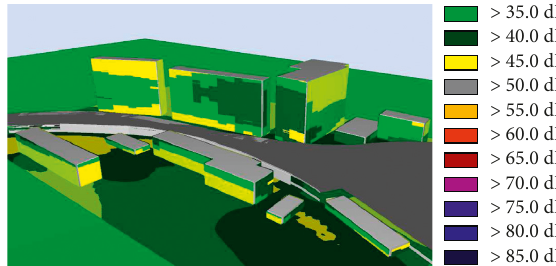
Figure 18: Noise map calculated with